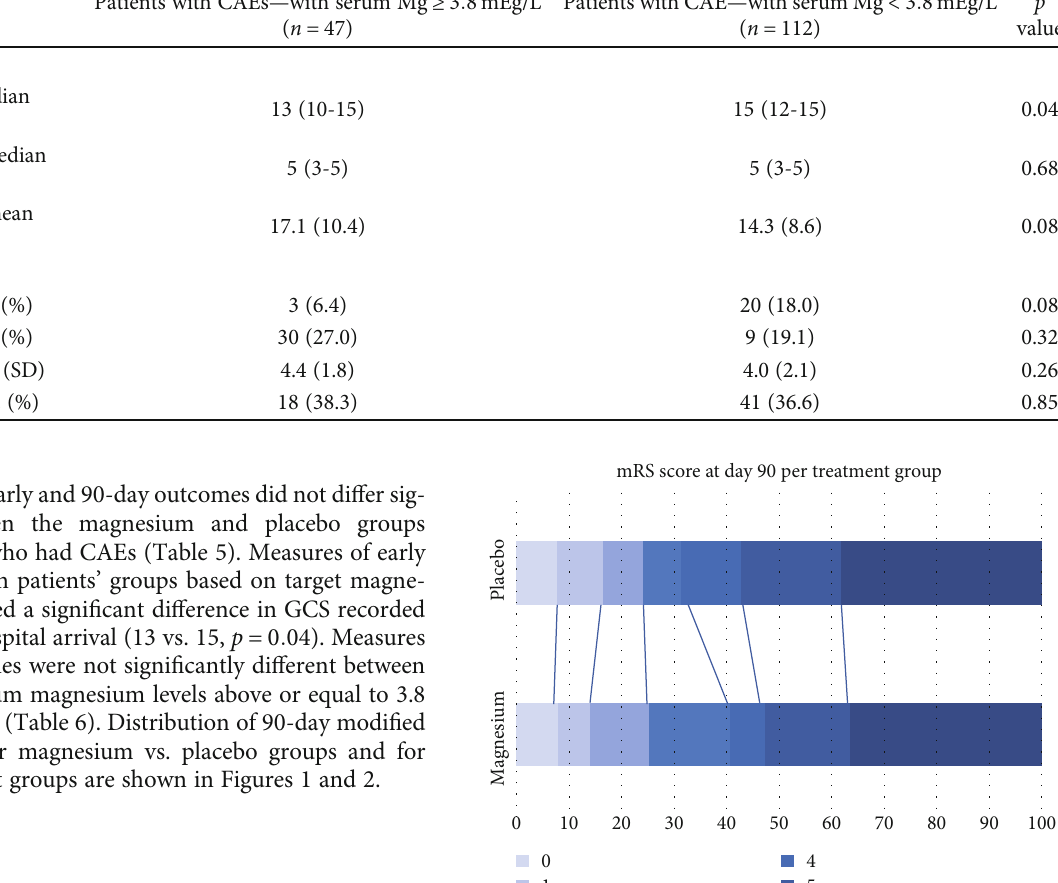
Table 6: Outcomes for patients with CAEs in patients by serum magnesium target group. Patients with CAEs — with serum Mg ≥ 3 : 8mEg/L